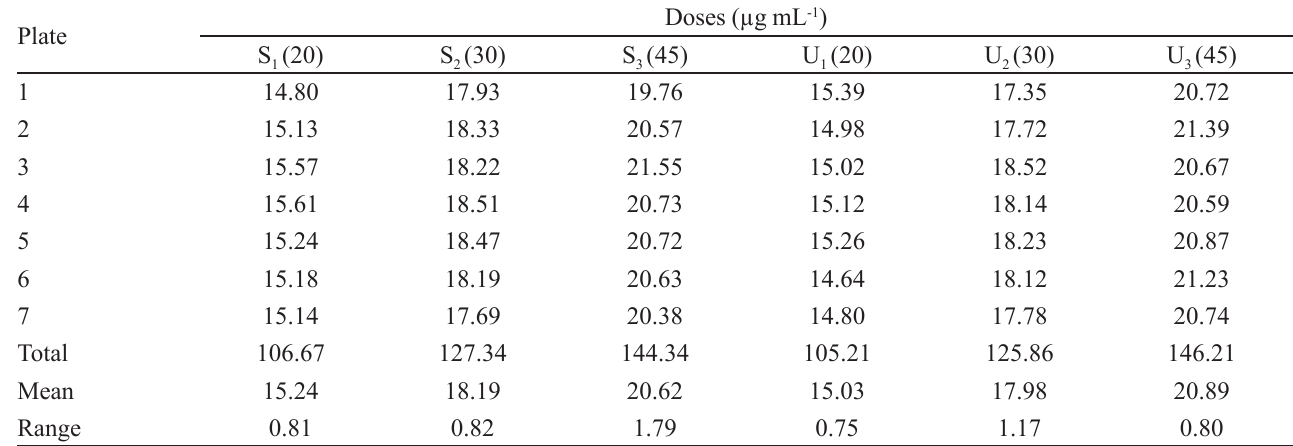
TABLE II – Diameters of inhibition zone (mm) of the ofloxacin microbiological assay using three-dose level (3x3) Plate